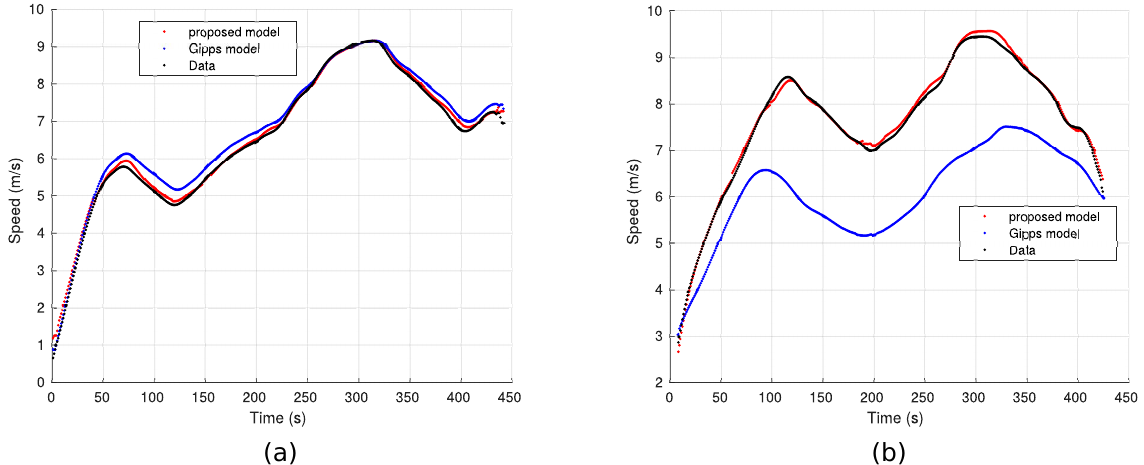
Figure 9. Prediction of real world test data by the proposed model and Gipps model: ( a ) using the test data from driver B’s driving data; ( b ) using the test data from driver C’s driving data. Table 5. Root mean square error ( rmse ) prediction